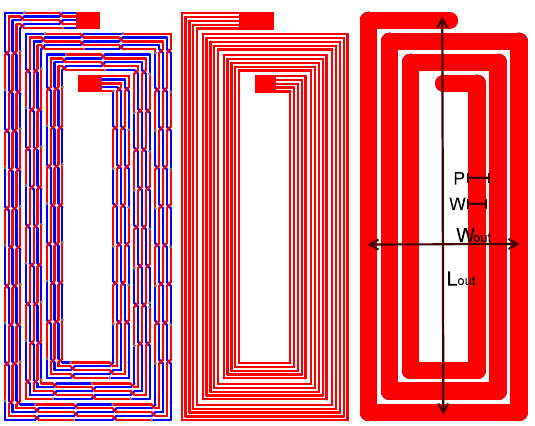
Figure 5. Litz PCB 3 turn winding ( Left ), multi-strands winding ( Middle ) and solid PCB winding ( Right